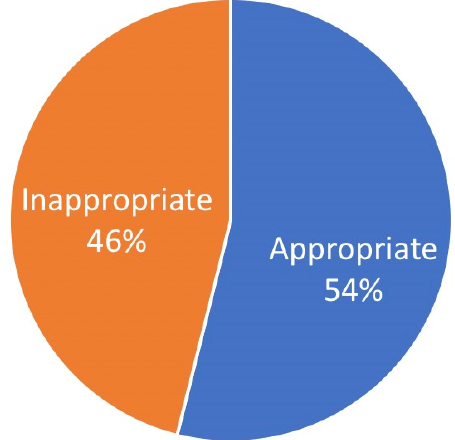
Figure 2. Appropriateness of referral diagnosis.